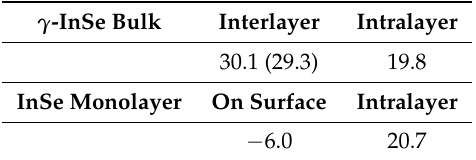
Table 1. Binding energies of H 2 and InSe in different configurations, as determined using DFT. Binding energies are measured in kJ mol − 1 . For all four cases, we consider the adsorption of a single H 2 molecule in a sufficiently large supercell. Only the atomic positions were allowed to relax while the cell parameters were kept fixed. For interlayer incorporation of a single H 2 molecule in bulk InSe, we performed an additional calculation in which we also relaxed the cell parameters. The calculated binding energy is shown in